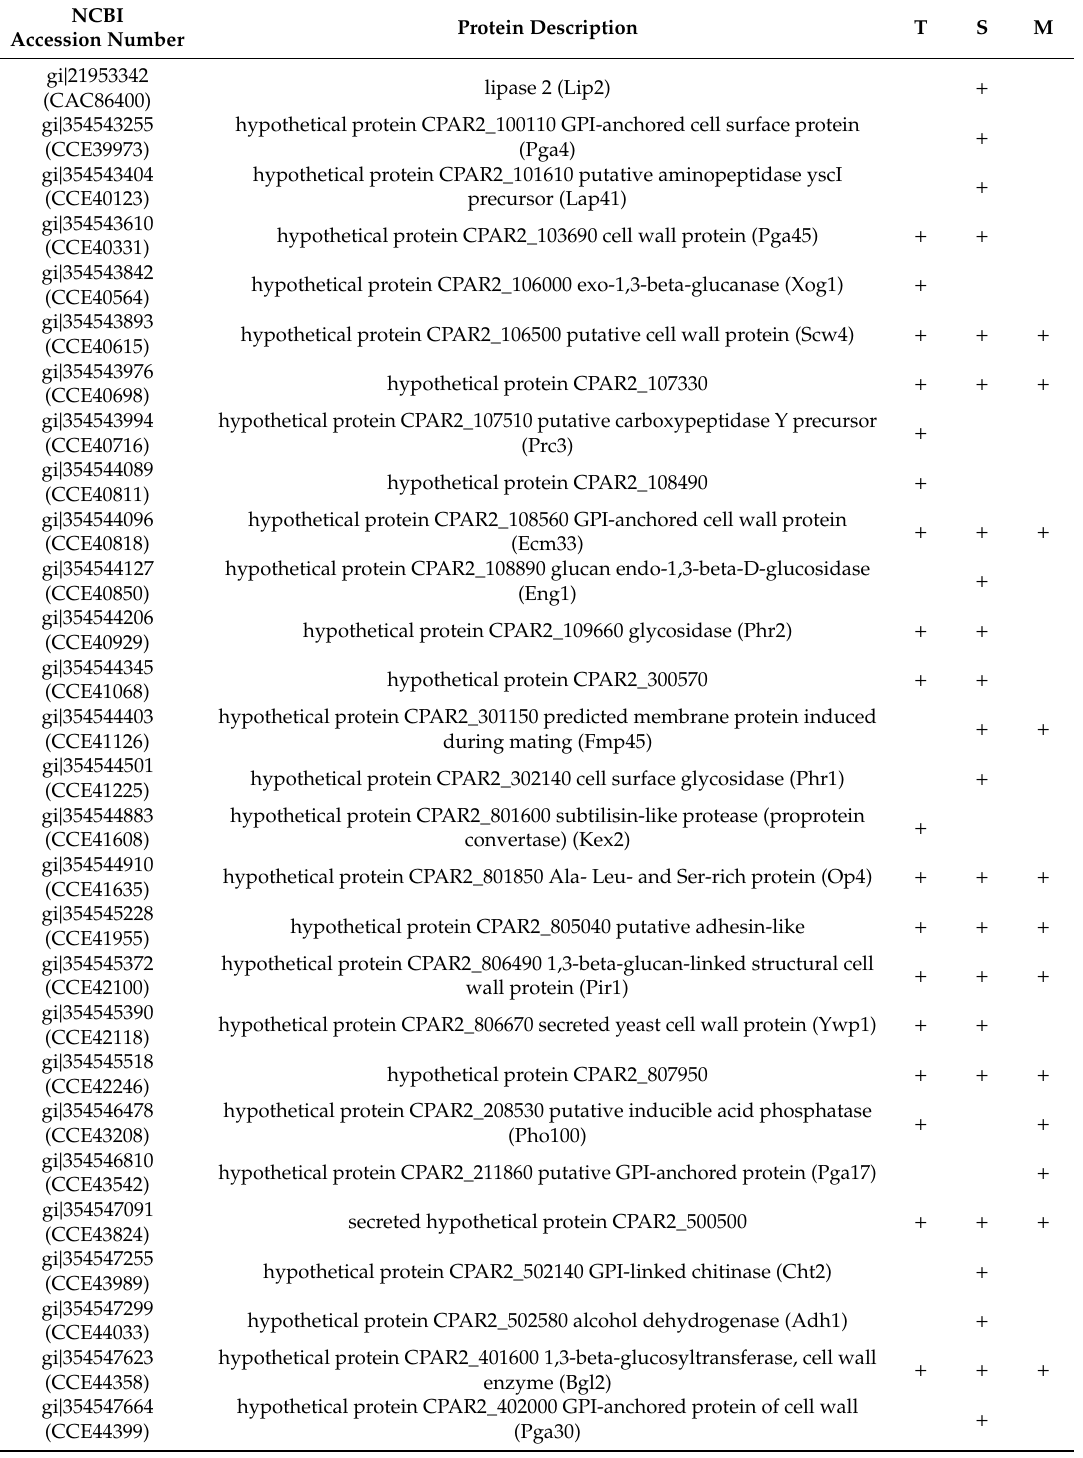
Table 4. Mass spectrometry identification of abundant proteins in C. parapsilosis EVs after vesicle surface shaving with trypsin (T) or vesicle sonication (S), and in EV membrane protein-enriched fractions (M). The resulting peptides were analyzed using the Dionex Ultimate 3000 UHPLC system coupled to an HCTUltra ETDII mass spectrometer and the obtained lists of peaks were searched against the NCBI protein database using an in-house Mascot